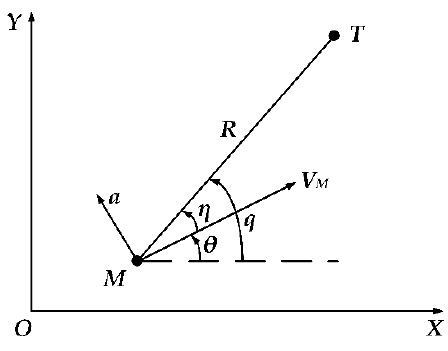
Figure 1. Planar homing engagement geometry.